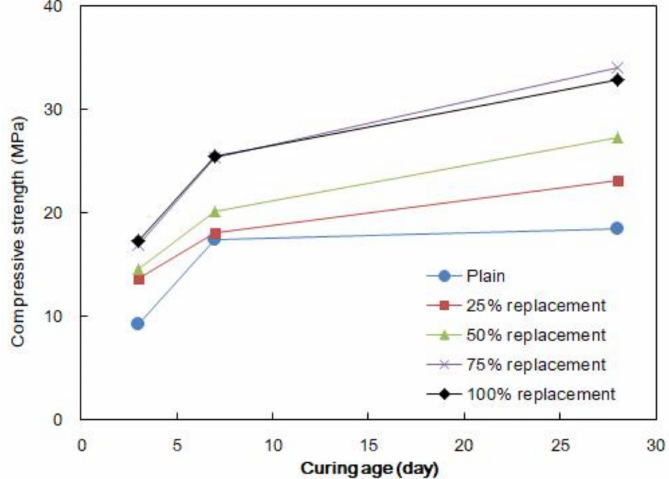
Figure 5. Compressive strength of cement mortar with borosilicate glass.